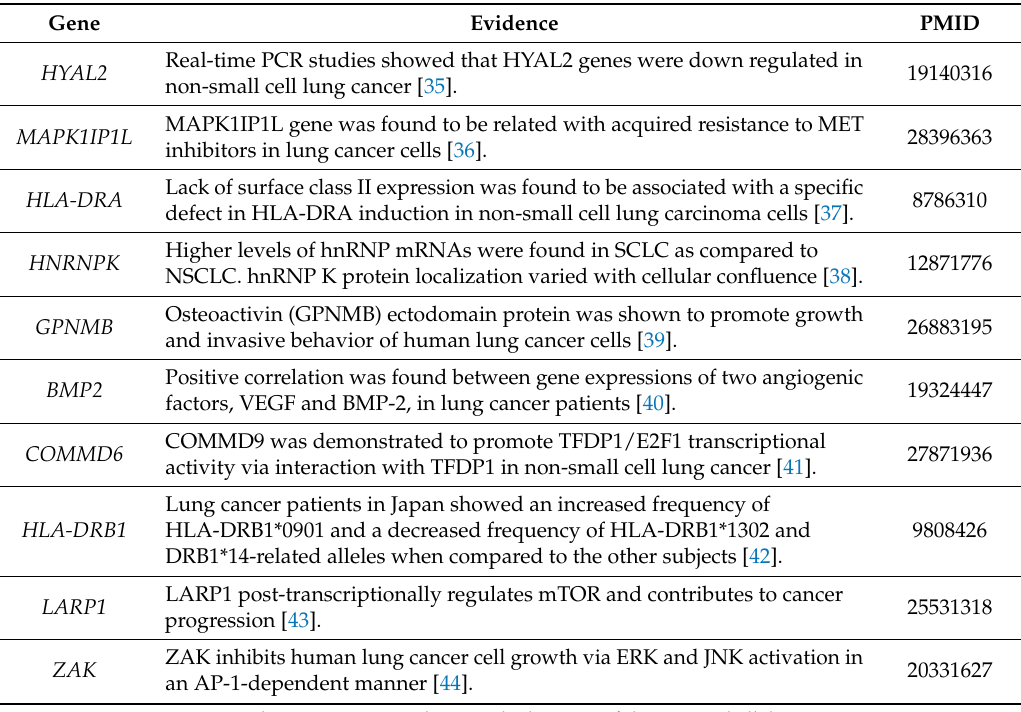
Table 2. Analysis of LUAD data: representative identified